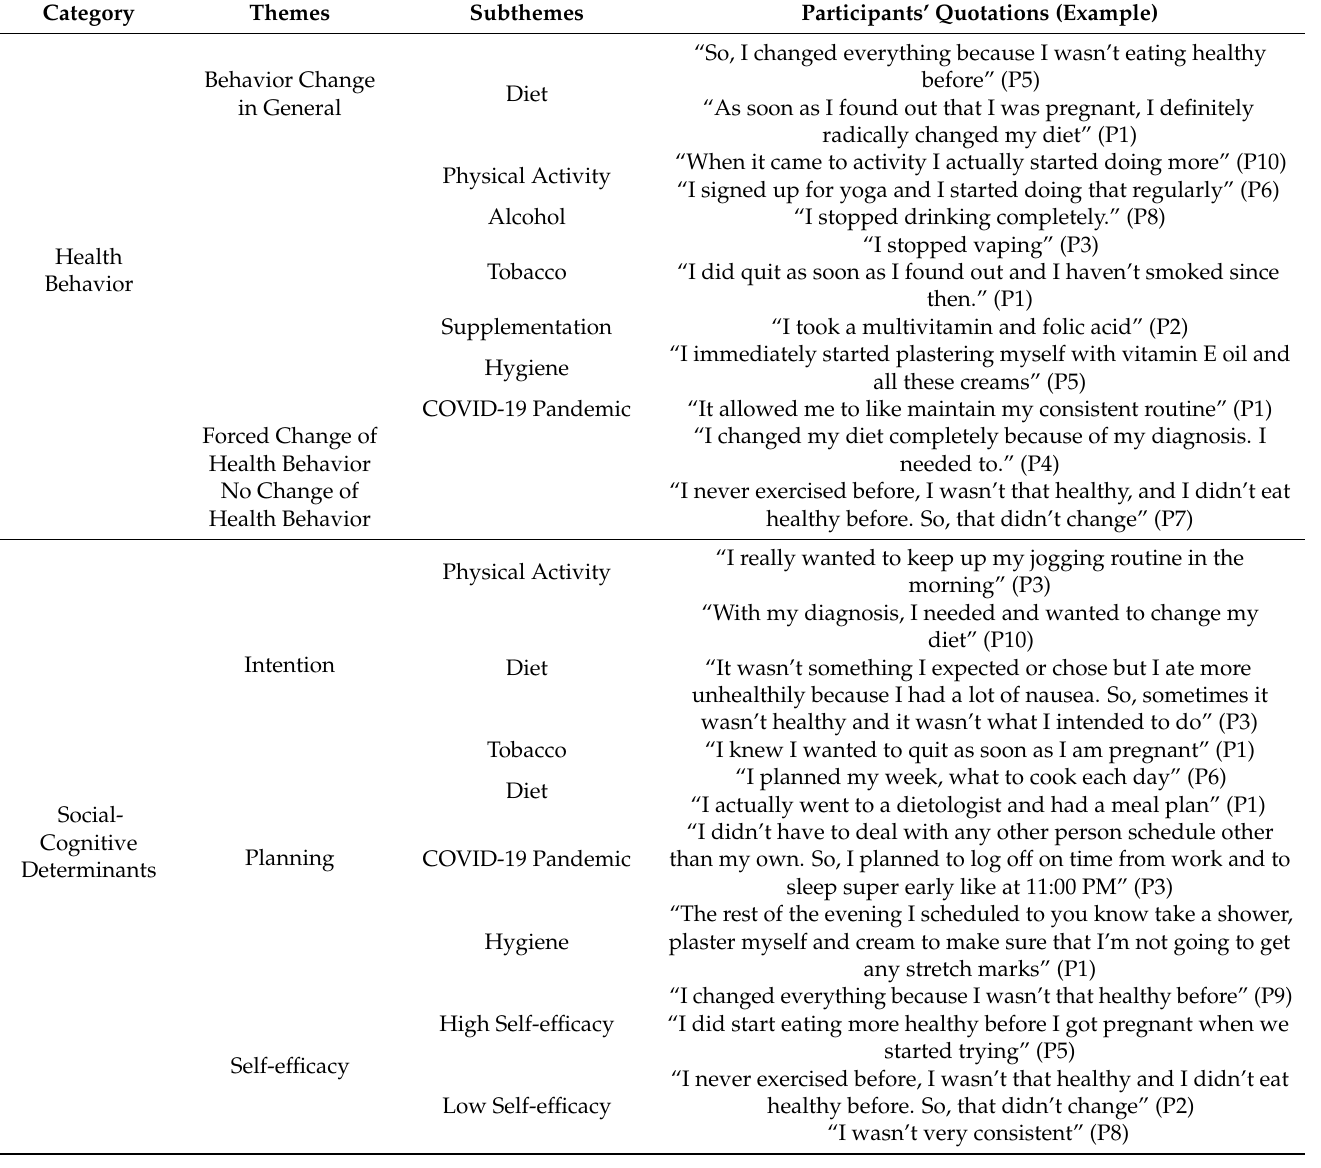
Table 2. Overview of the participants’